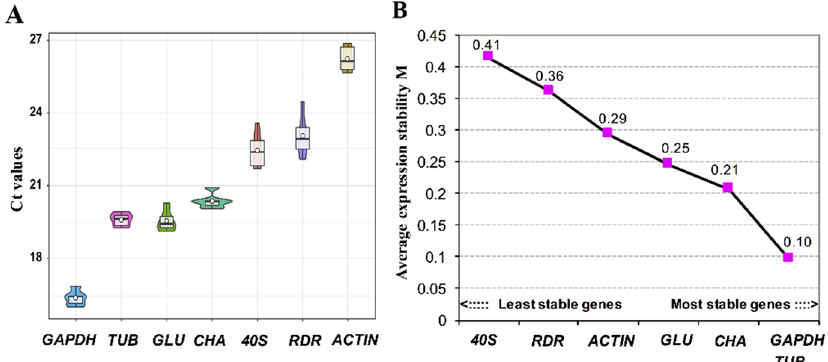
Figure 4. Housekeeping gene expression in nutrient-replete and + 1 / 5Fe, –Mn, + 1 / 5Zn, –Cu, –Ni deficient conditions: ( A ) Boxes of seven housekeeping gene expressions. ( B ) The stability and ranking of the selected genes shown from A calculated by geNorm. TUB : tubulin; GLU : beta-glucanase; CHA : chaperone protein; 40S : 40S ribosomal protein S4; RDR : ribonucleoside-diphosphate reductase.